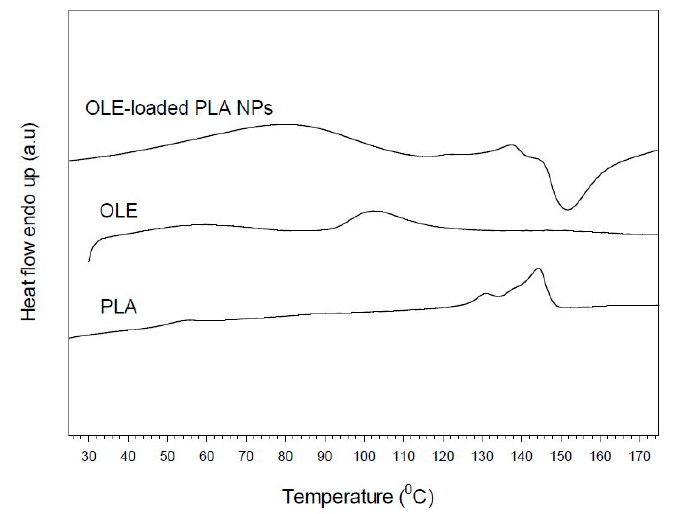
Figure 5. Differential scanning calorimetry (DSC) thermograms of pure poly(lactic acid) (PLA), olive leaves extract (OLE), and PLA nanoparticles loaded with oil leaves extract (OLE-loaded NPs).